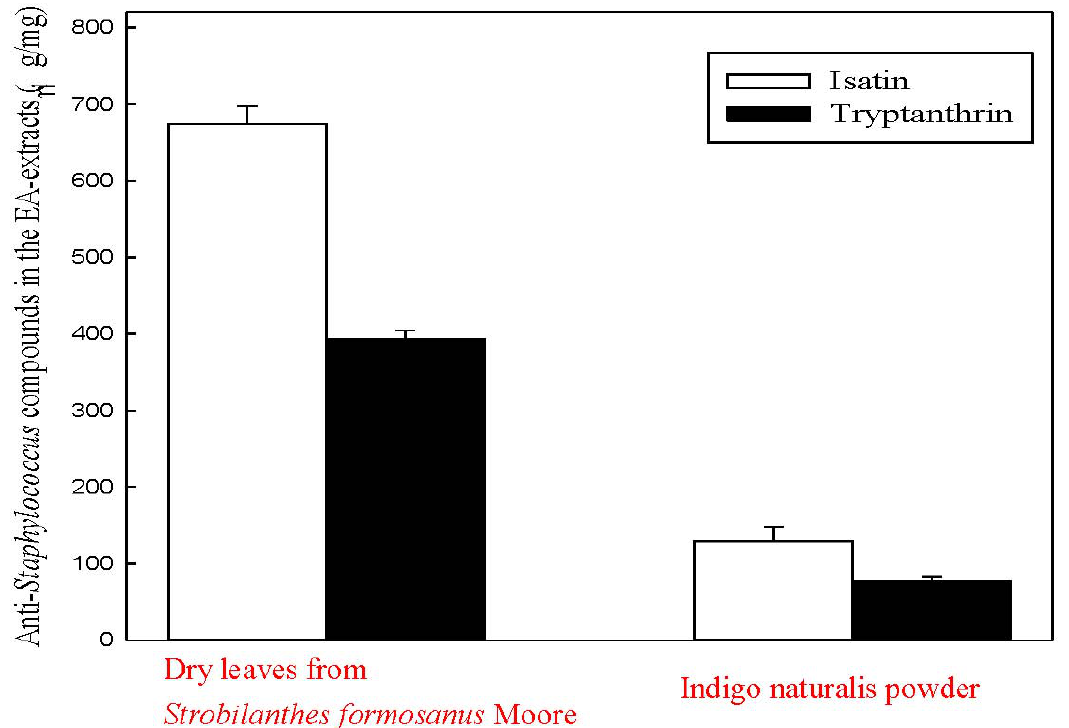
Figure 3. HPLC quantification of the anti- Staphylococcus compounds (isatin and tryptanthrin) in the EA-extracts of the indigo naturalis powder and the dry leaves from Strobilanthes formosanus